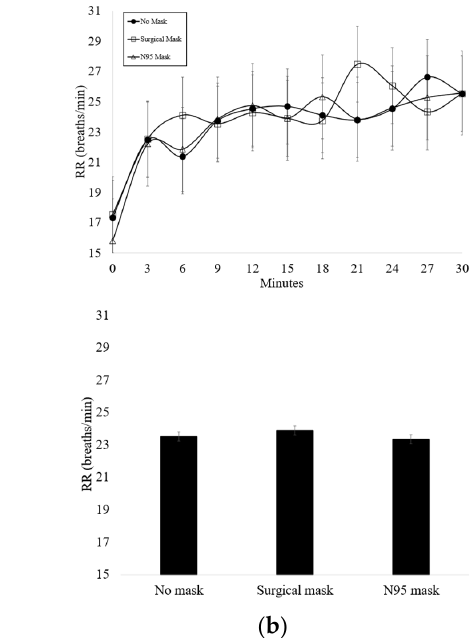
Figure 2. ( a ) Average heart rate (HR) (mean ± SD) during each testing condition ( n = 19) * Signifi- cant main effect for condition ( p < 0 .05); ( b ) average respiratory rate (RR) (mean ± SD) during each testing condition ( n = 19).